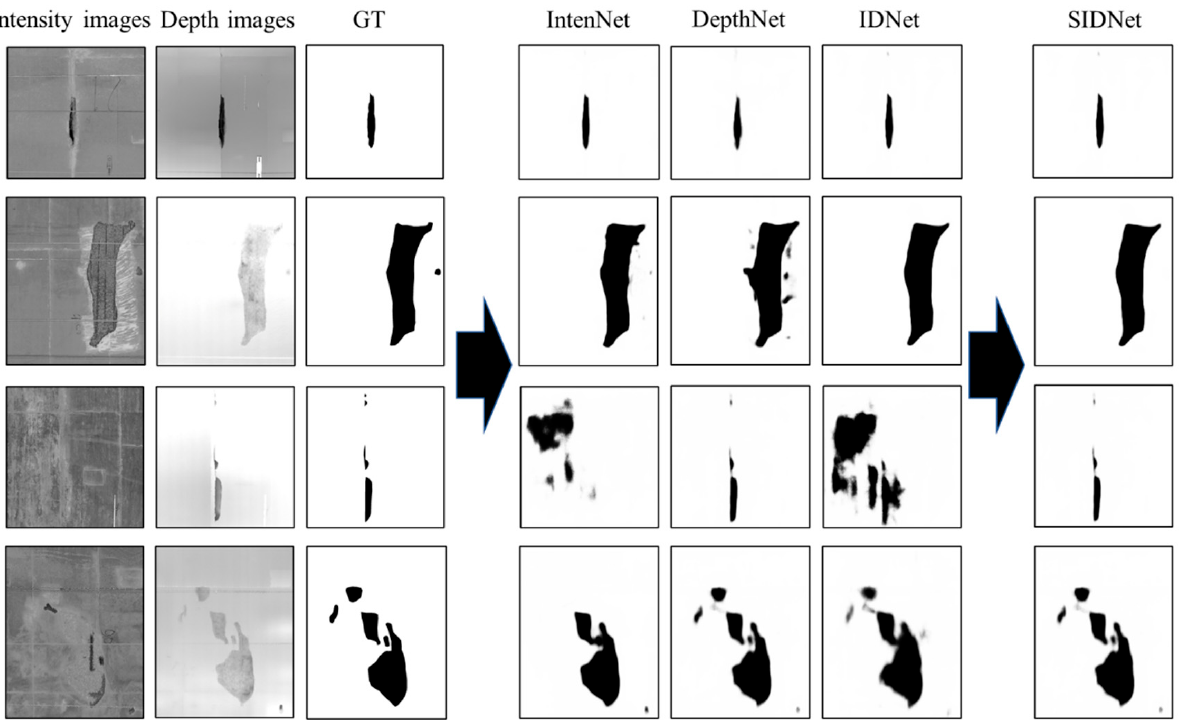
Figure 11. Examples of the spalling detection results output from the three DCNNs and the SIDNet. To verify the effectiveness of the IDU module, the performances of three DCNNs (IntenNet, IDNet, and DepthNet) were compared with the performance of the SIDNet and the D 3 Net. As shown in Table 2, the IDNet (0.970 and 0.911) performed slightly better